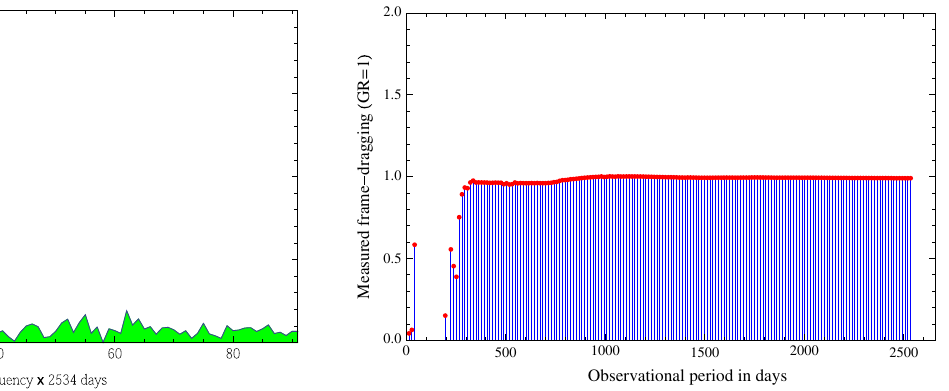
Fig. 4 Fourier analysis of the combined residuals of LARES, LAGEOS and LAGEOS 2, over about 7 years of orbital observations, after removal of the five main residual tidal signals and of a constant trend. In the horizontal axis is the frequency times 2534 days. In the ver- tical axis is the absolute value of the Discrete Fourier Transfom | F ( n ) | . The figure shows that there are no relevant long-period signals left after the removal of the six main tidal signals. The remaining higher frequen- cies n do not significantly contribute to the secular trend fitted for over the observational period of 7 years